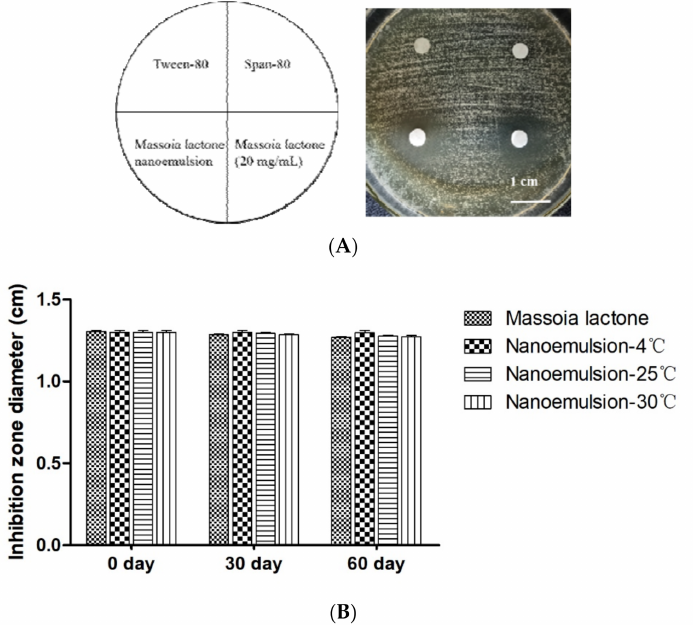
Figure 4. Antifungal activity ( A ) and stability of anti-fungal activity ( B ) of the Massoia lactone loaded NEs and free Massoia lactone. Data are given as mean ± SD, n =